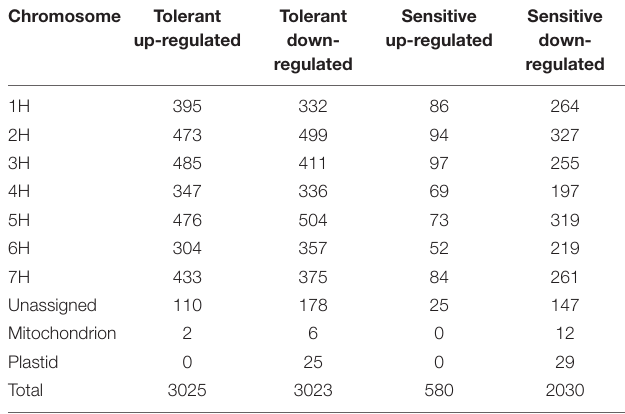
TABLE 2 | The differentially expressed genes (DEGs) between the control and salt-treated groups were assigned to seven barley chromosomes in two barley subspecies (wild salt-tolerant genotype and ‘Mona’ salt-sensitive